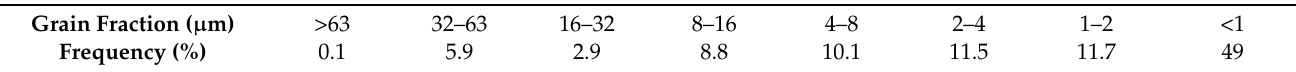
Table 2. Particle size distribution of Borkowice